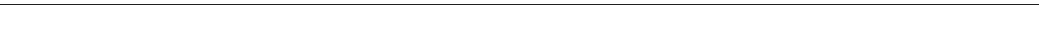
Fig. 2 Signal II triggers depletion of sumoylated NLRP3. a Nigericin treatment results in the reduction of sumoylated NLRP3. HEK293T cells expressing FLAG-NLRP3 were stimulated with nigericin for the indicated time points. FLAG-NLRP3 immunoprecipitates were analysed for sumoylation (upper panel) and ubiquitylation (middle panel). SUMO and ubiquitin smears were quanti fi ed using Image Lab Software (Bio-Rad) and the modi fi cation normalised to total immunoprecipitated NLRP3. Graphs represent fold change compared to untreated cells. The effect of nigericin stimulation on global SUMO-2/-3 levels was determined by immunoblot analysis of total cell lysates. The data depict representative immunoblots of three independent experiments. b Endogenous NLRP3 interacts with SUMO-2/-3, but the interaction is lost upon NLRP3 activation by treatment with LPS and nigericin (left panel) or ATP (middle panel). Immortalised WT or Nlrp3 − / − murine BMDMs were left untreated, primed with LPS for 4 h or treated with LPS (4 h) followed by 30 min with nigericin or 20min with ATP. Cells were fi xed and proximity ligation assay (PLA) was performed using α -NLRP3 and either α -SUMO-2/-3 (upper panel) or α -ASC antibodies (lower panel), as indicated. Representative confocal microscopy images are shown for each condition, which was repeated at least three times, except for ATP ( n = 1). Scale bar, 10 µ